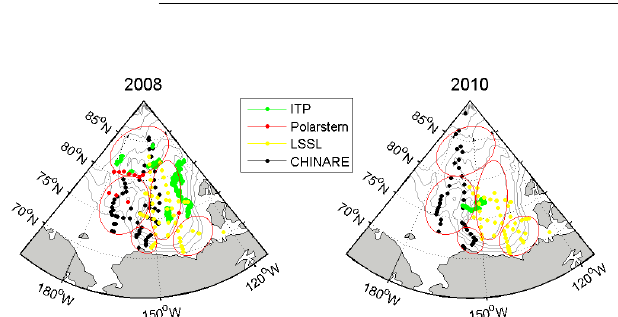
Figure 3: Location and source of both CTD and ITP data for years 2008 (left) and 2010 (right). The ellipses correspond to the subdivision chosen for the Canadian Basin.